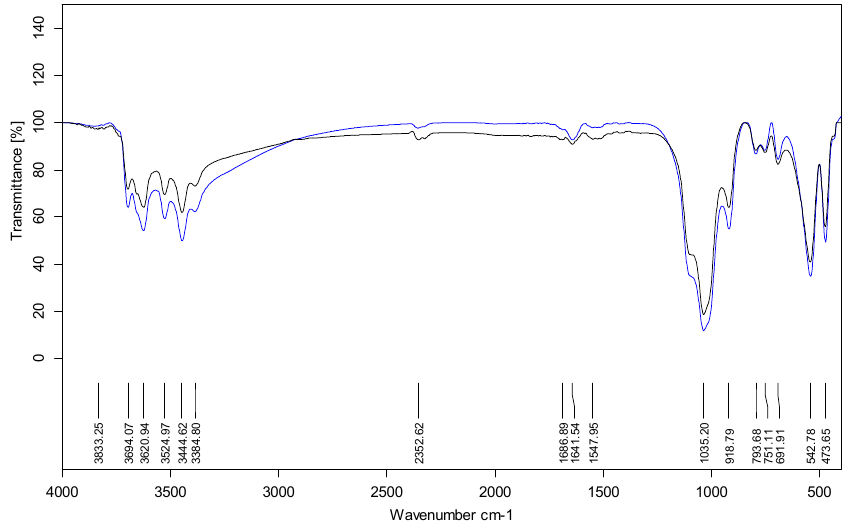
Figure 4. IR Spectra of Red Soil 1 Before and After Arsenate Adsorption.